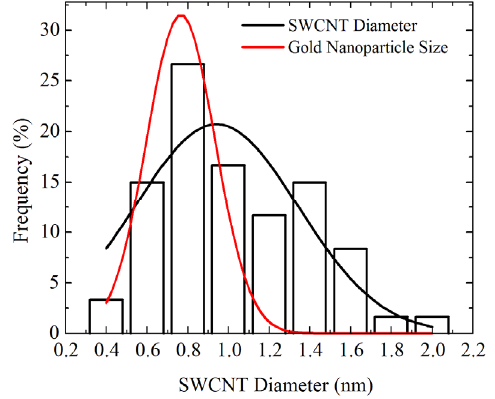
Figure 4. Comparison of size distribution between gold nanoparticles annealed for 120 min and SWCNTs